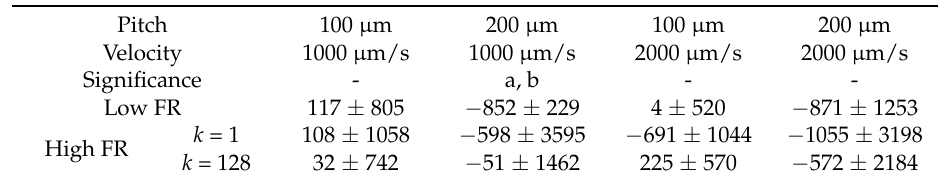
Table 1. Lateral estimation errors of the velocity given as the mean estimation error ± one standard deviation.